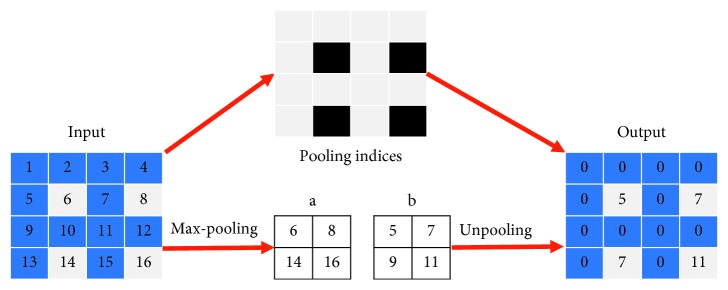
Unpooling operation.